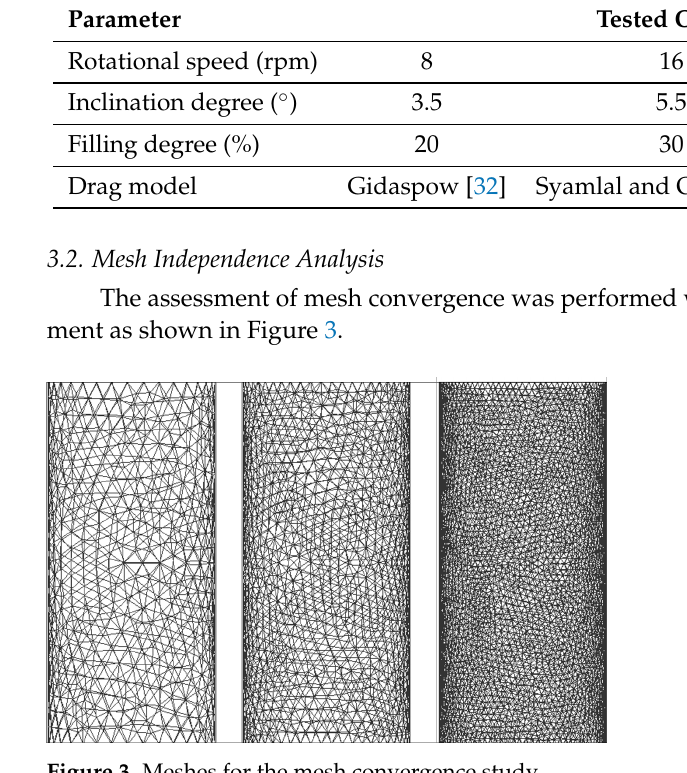
Figure 3. Meshes for the mesh convergence study.